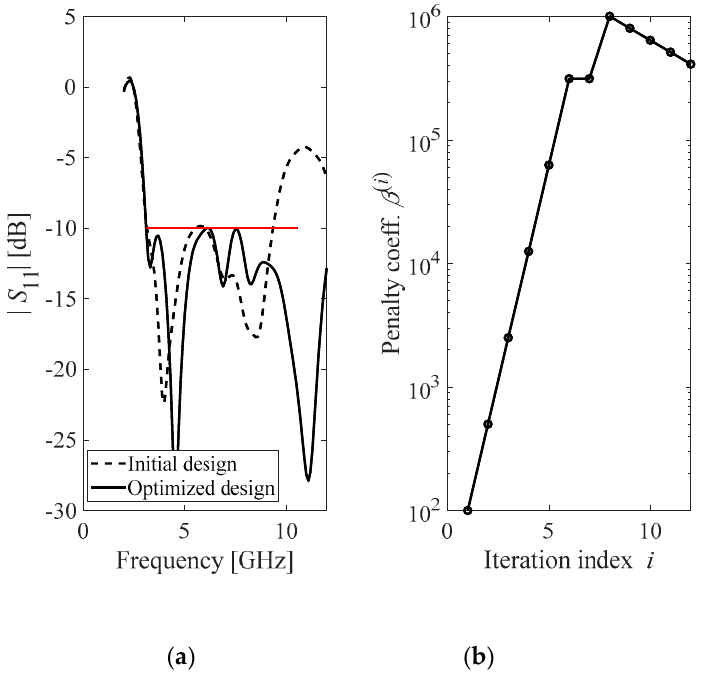
Figure 9. Antenna III: representative run of the proposed algorithm with automated adjustment of the penalty factors: ( a ) reflection coefficient at the initial (- - -) and optimized design ( — ); ( b ) evolution of the penalty coefficient throughout the algorithm iterations.